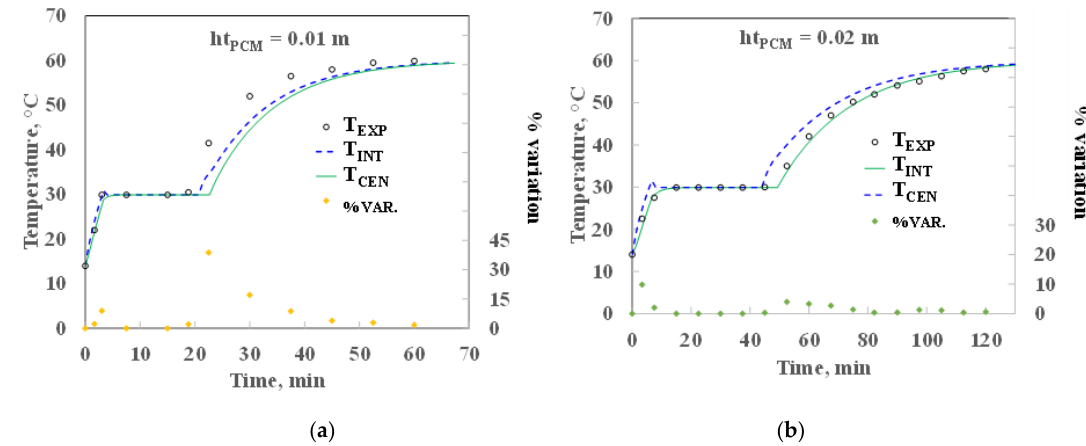
Figure 4. Validation of the simulation of a rectangular container at a PCM height of ( a ) 0.01 m and ( b ) 0.02 m.